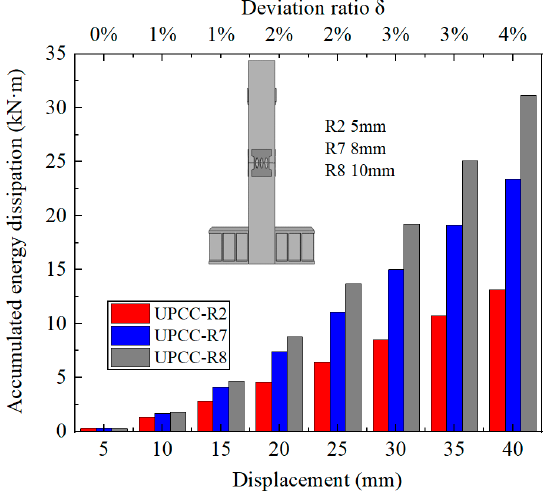
Figure 31. Cumulative energy dissipation curve under different EREDL thickness.